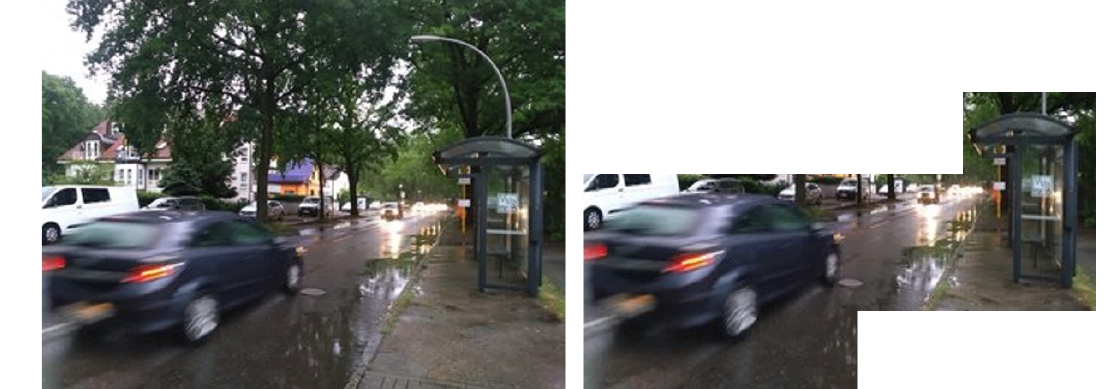
Figure 3. Traffic situations. Edited by the authors based on images from the ‘meinBerlin’ platform.